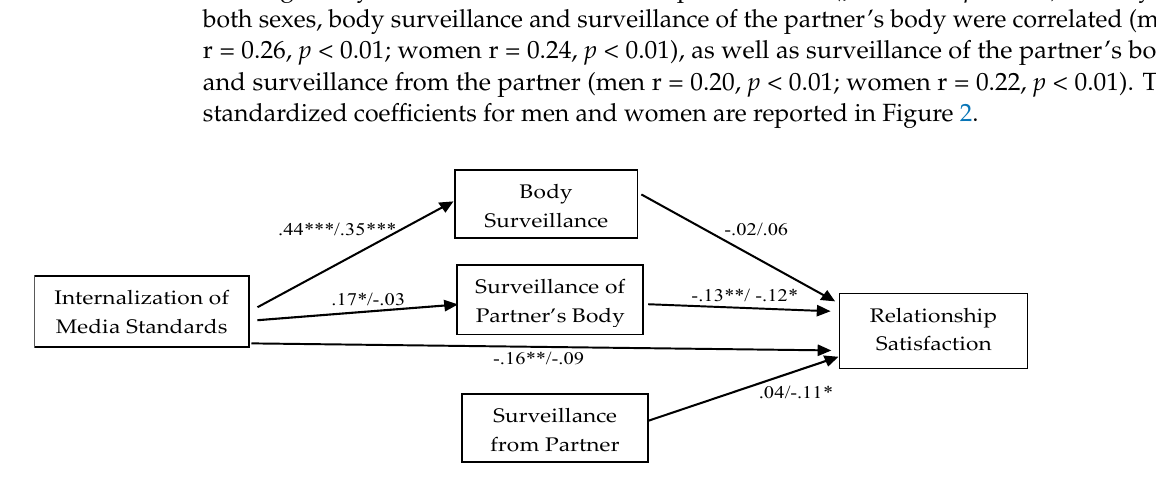
Figure 2. Standardized path coefficients of the hypothesized model for men and women, respectively. * p < 0.05; ** p < 0.01; *** p < 0.001.